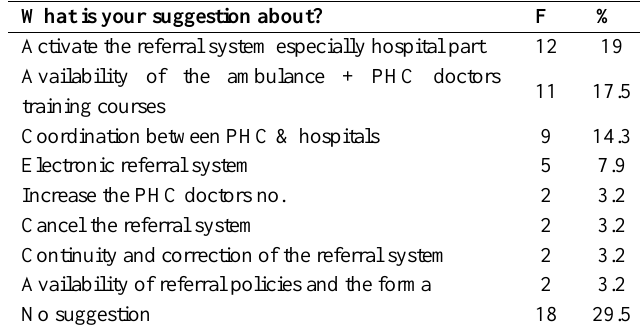
Table 6: participant doctor's suggestion to strengthen the current referral system.